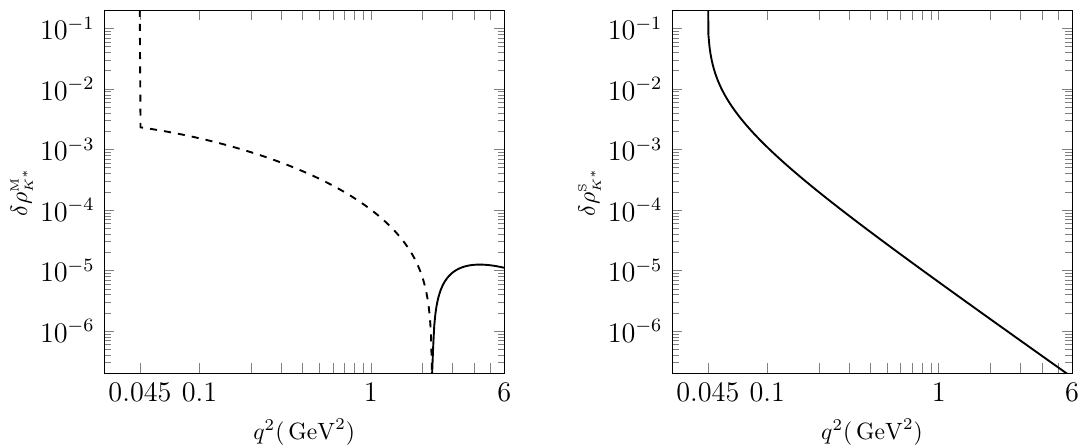
Figure 6 . The (cid:14)(cid:26) M (magnetic-dipole) and (cid:14)(cid:26) S (Sommerfeld) corrections, as de(cid:12)ned in the text, K (cid:3) K (cid:3) as a function of q 2 , in the left and right plots